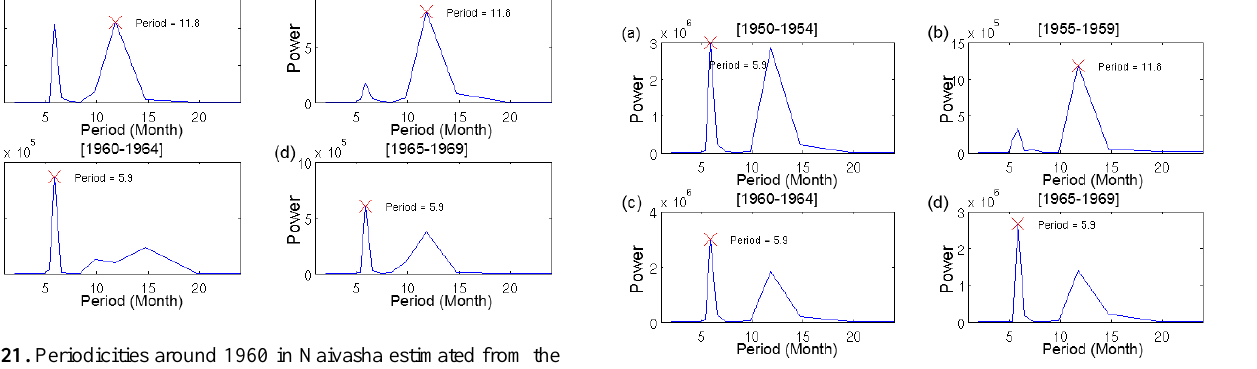
Fig. 22. Periodicities around 1960 in Narok estimated from the rep- resentative time series of the harmonics. (a) shows the periodicities between 1950 and 1954, (b) between 1955 and 1959, (c) between 1960 and 1964, and (d) between 1965 and 1969. The red cross mark means the major periodicity in each time region.